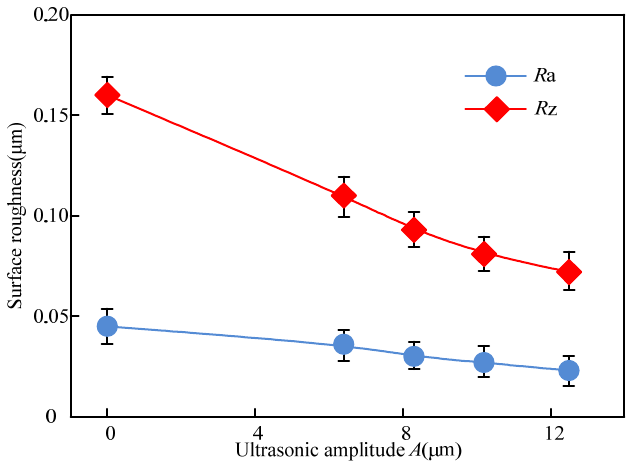
Figure 13. Variation of surface roughness with ultrasonic amplitude.